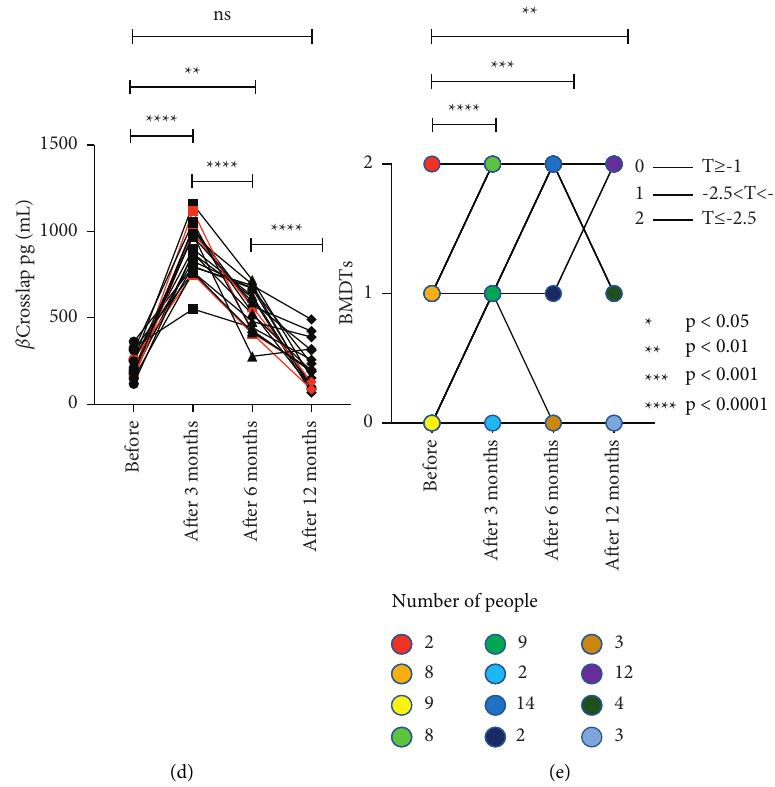
Figure 5: The change of bone loss biomarkers during pre and postlung transplantation at the point of before transplantation, month 3 after transplantation, month 6 after transplantation, and month 12 after transplantation. (a) The change of 25-VITD. (b) The change of OSTEOC. (c) The change of P1NP. (d) The change of beta-CrossLap. (e) The change of BMDTs. 0 means the T value ≥ − 1; 1 means − 2.5 < T value < − 1; 2 means T value ≤ − 2.5. ∗ , P value < 0.05. ∗∗ , P value < 0.01. ∗∗∗ , P value < 0.001. ∗∗∗∗ , P value < 0.0001. The line in red means female